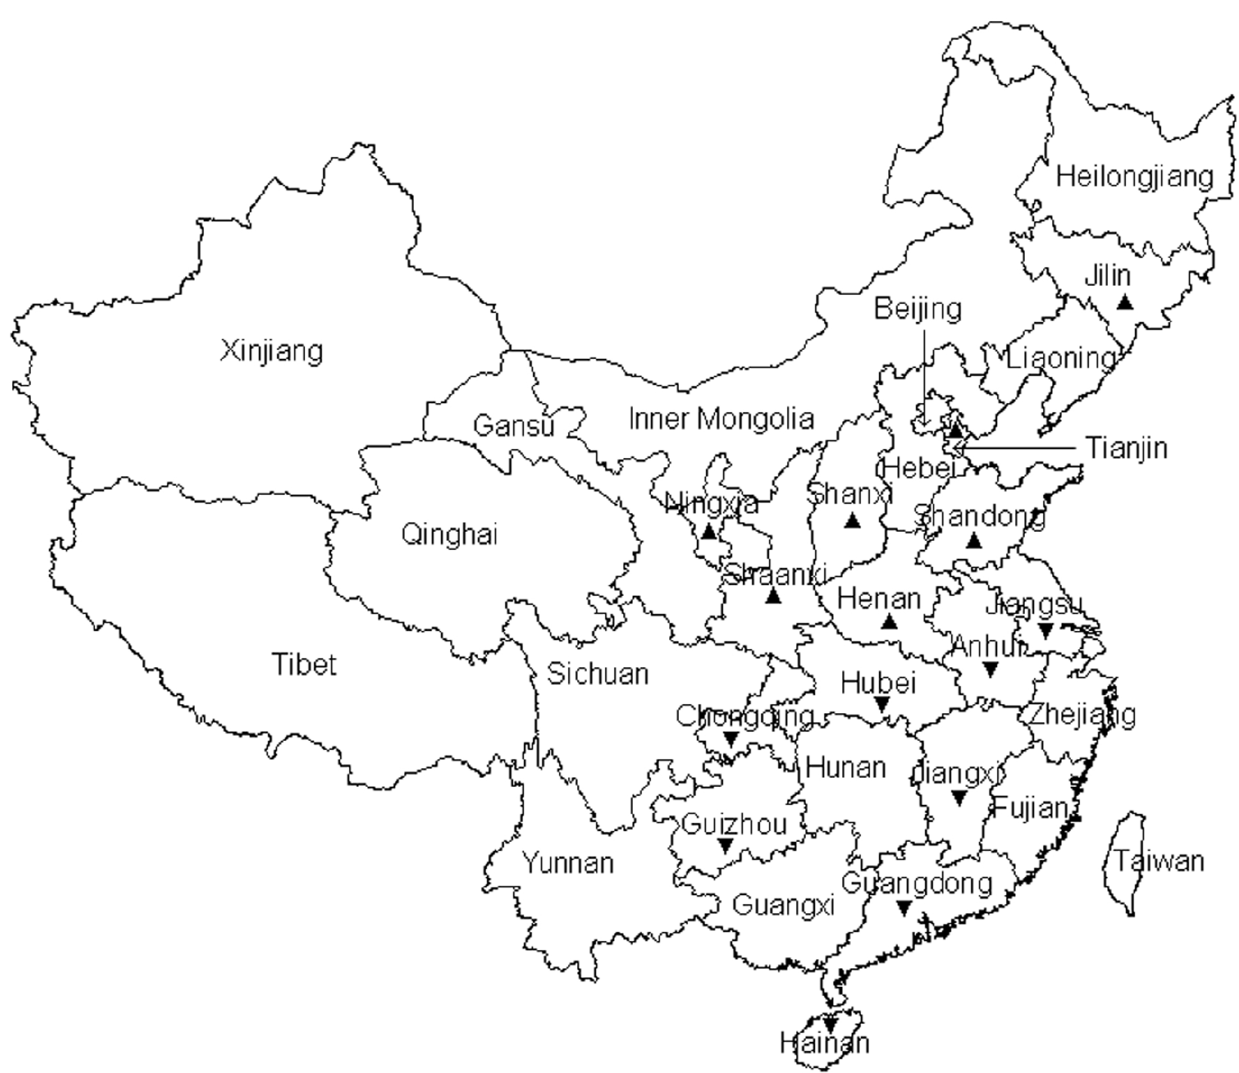
Figure 1. Provinces targeted for the eight surveys in 2008 2 2011 marked with ‘‘ m ’’ for those in Northern China or ‘‘ . ’’ for those in Southern